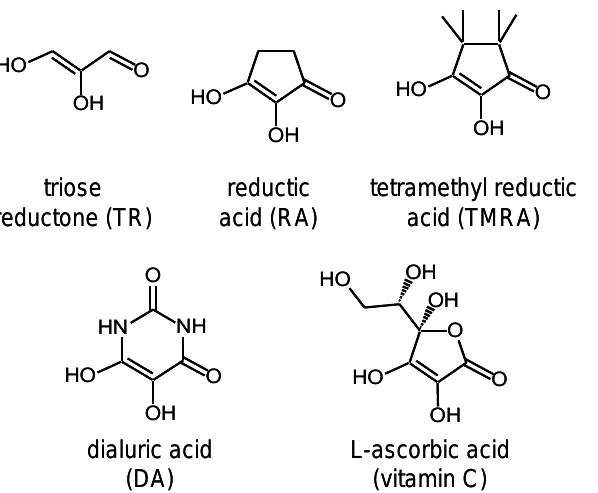
Figure 3. A selection of reductones. The present NMR study deals with the tautomerization of tetramethyl reductic acid (TMRA) in CD 2 Cl 2 and toluene- d 8 . The hydrogen bond patterns in the crystalline states of the TR, RA and TMRA are depicted schematically in Figure 4. In TR and RA, the two OH groups form hydrogen bonds with the C=O groups of two neighboring molecules [31,32]. In crystalline TMRA there are two inequivalent molecules, A and B [33]. The two OH groups of B form two hydrogen bonds with the C=O group of molecule A. The central OH group of the latter forms a hydrogen bond with the central OH group of molecule B, and the peripheric group with the C=O group of B. The O…O hydrogen bond distances in all cases are around 2.6–2.7 Å.